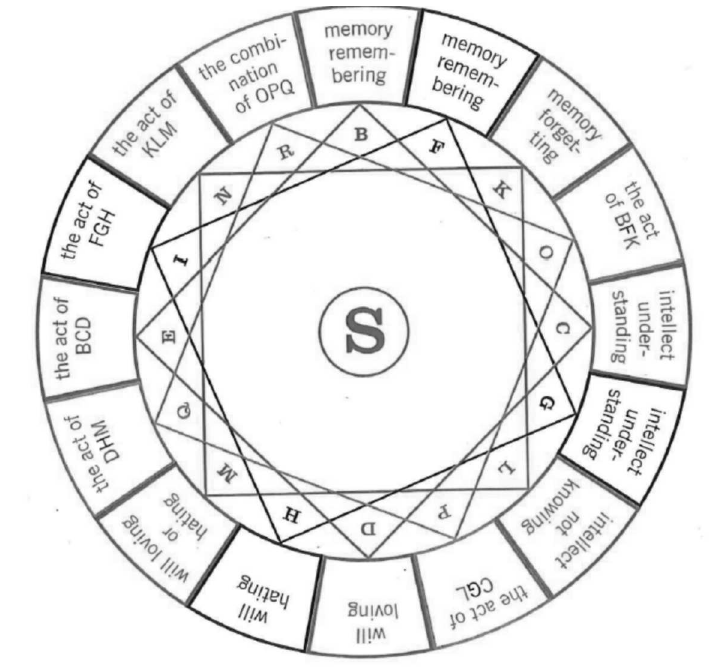
Figure 5. The acts of the rational soul (Bonner, 2007). Courtesy of Koninklijke Brill NV, Leiden The